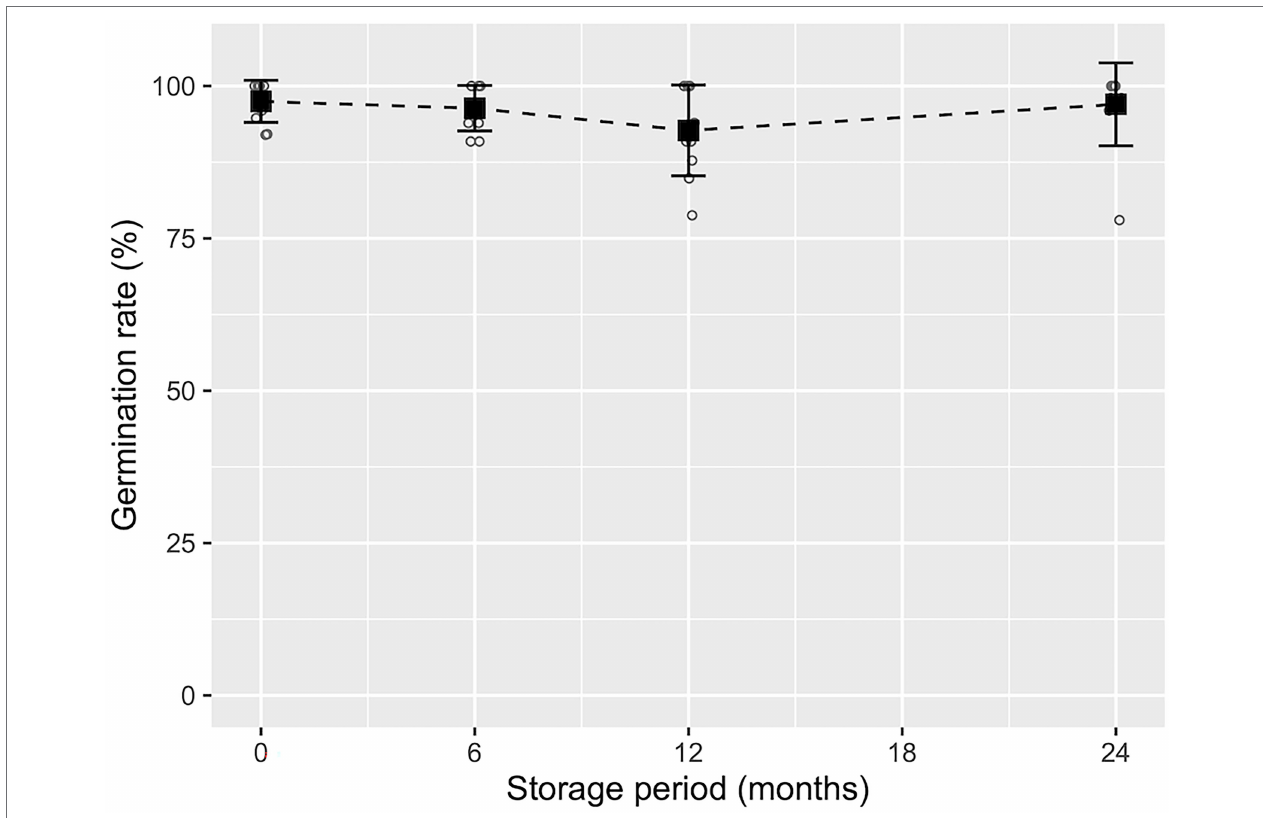
FIGURE 7 | Germination frequency of pollen-free sugi ( C. japonica ) somatic embryos derived from the SSD-018 embryogenic cell line after different storage periods. The average germination frequency (black square) with error bars (±SD) at each storage period is shown above the measurements (white circles).